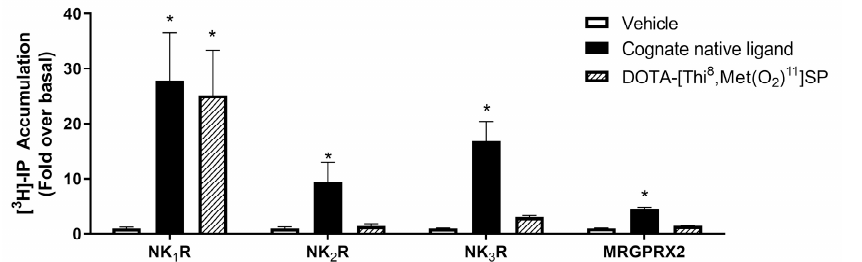
Figure 2. Receptor activation by DOTA-[Thi 8 ,Met(O 2 ) 11 ]SP. HEK293-T cells transfected with NK1R, NK2R, NK3R or MRGPRX2 were incubated with 1 µM (NK1R, NK2R or NK3R) or 10 µM (MRGPRX2) of DOTA-[Thi 8 ,Met(O 2 ) 11 ]SP or native ligand (SP: NK1R and MRGPRX2; NKA: NK2R or NKB: NK3R) and receptor activation was measured using an IP accumulation assay. Data are presented as fold- over-basal (measured in the presence of vehicle) and are mean ± SEM ( n ≥ 3). * p < 0.05 for comparison with vehicle (one-way ANOVA followed by Dunnett’s post hoc test).